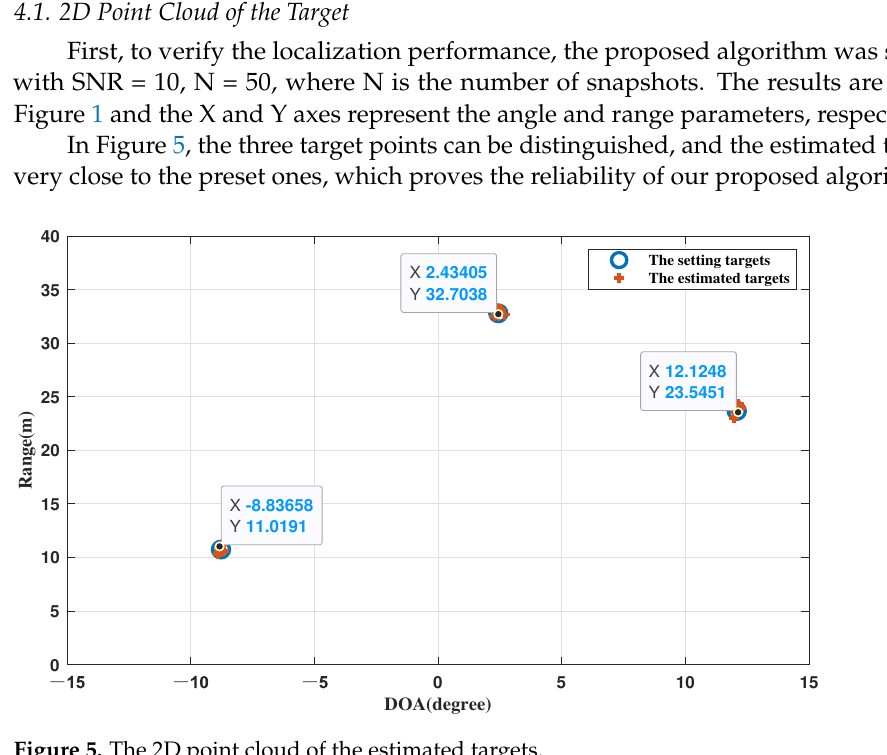
Figure 5. The 2D point cloud of the estimated